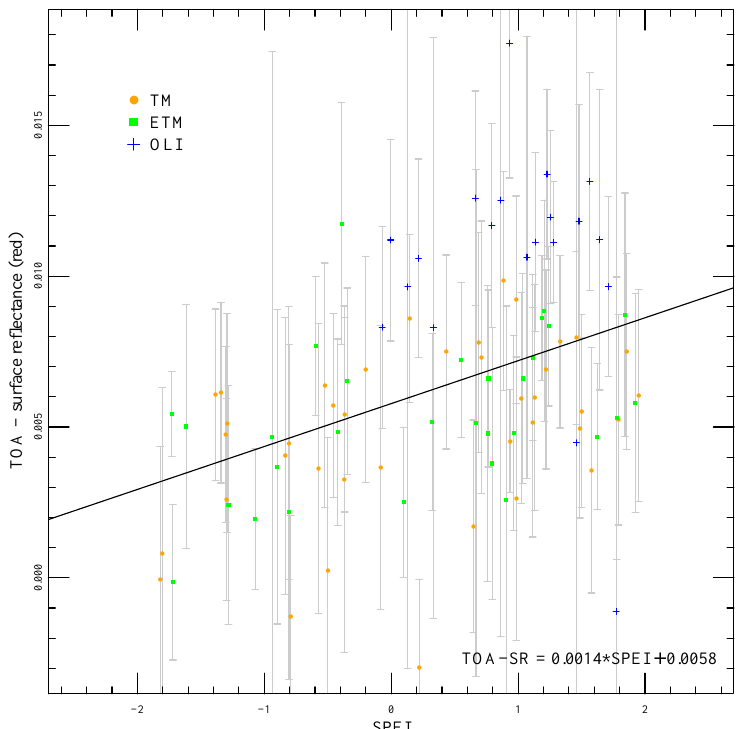
Figure 6. SPEI versus the mean difference of TOA minus surface reflectance (SR) for 90 Landsat observations for the red band. Note that the range in reflectance difference is ∼ 0.015, compared to a range of ∼ 0.1 in Figure 5. The grey lines show one standard deviation around the mean difference. The black line is the regression fit. Orange circles are TM observations, green squares ETM+, and blue pluses